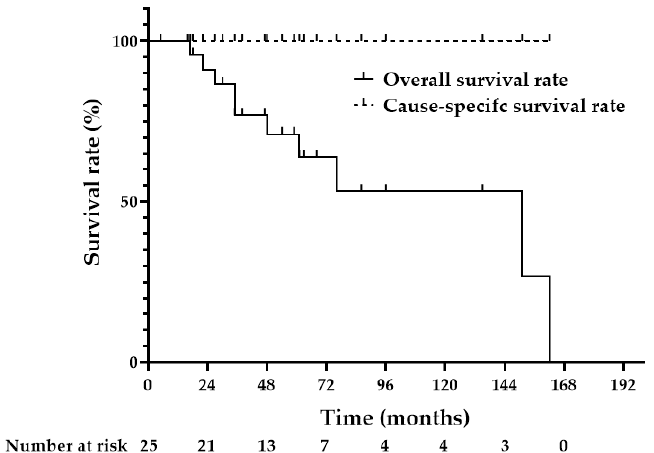
Figure 4. Overall and cause-specific survival rates. The 5-year overall and cause-specific survival rates are 71.0% and 100%, respectively.